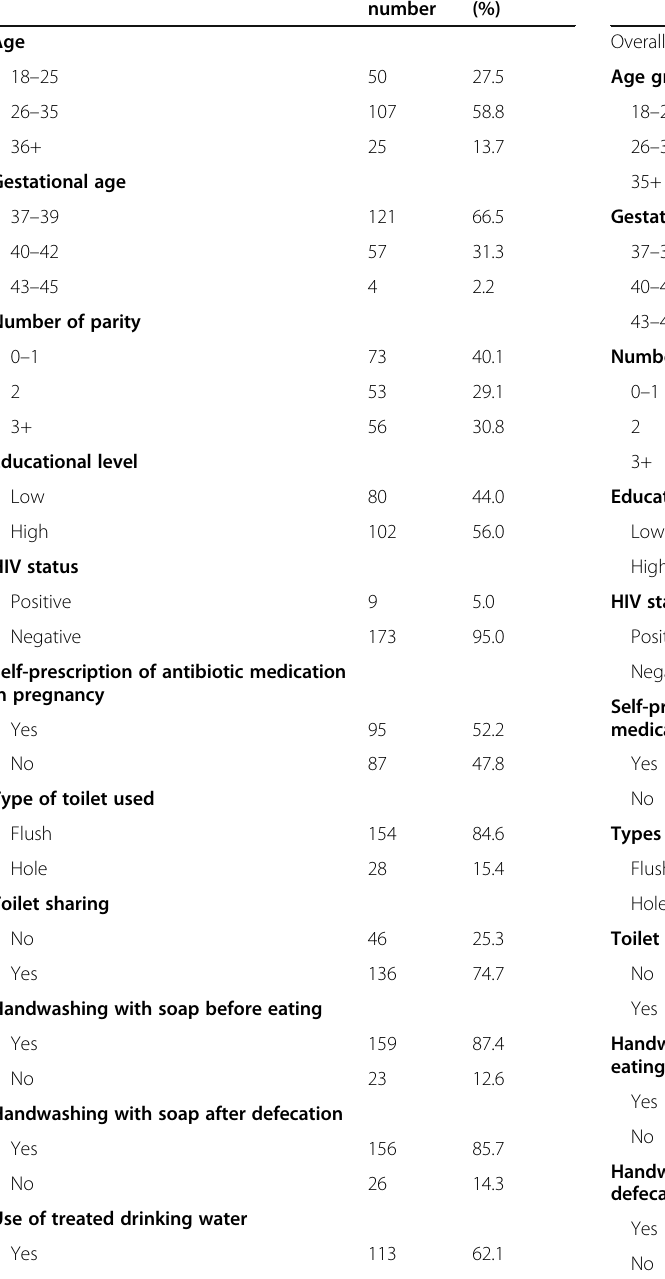
Table 2 Fecal carriage of ESBL-E among pregnant women by social-demographic, clinical factors, and hygienic factors